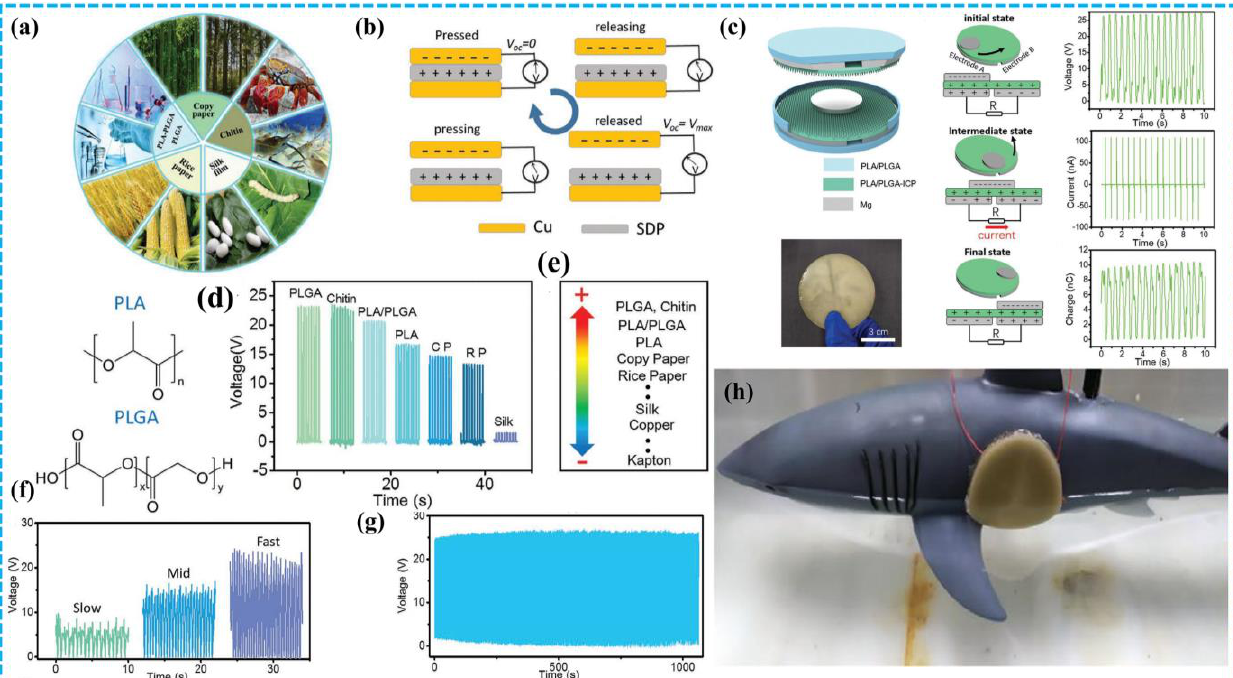
Figure 13. TENG based on synthetic degradable polymer for blue energy harvesting: ( a ) triboelec- trification properties of biodegradable materials, and biodegradable materials from different sources; ( b ) the scheme of the working mechanism of a contact-separation TENG; ( c ) a structure diagram, photograph, and working mechanism of the SD-TENG and V oc , I sc , Q sc .; ( d ) the open-circuit voltage of the TENG using different SDP materials; ( e ) a brief tribo-series of biodegradable materials; ( f ) output voltage of SD-TENG at different vibration speeds; ( g ) the stability of the SD-TENG for about 1000 cycles; and ( h ) a photograph of a SD-TENG tested in water. Reproduced with permission